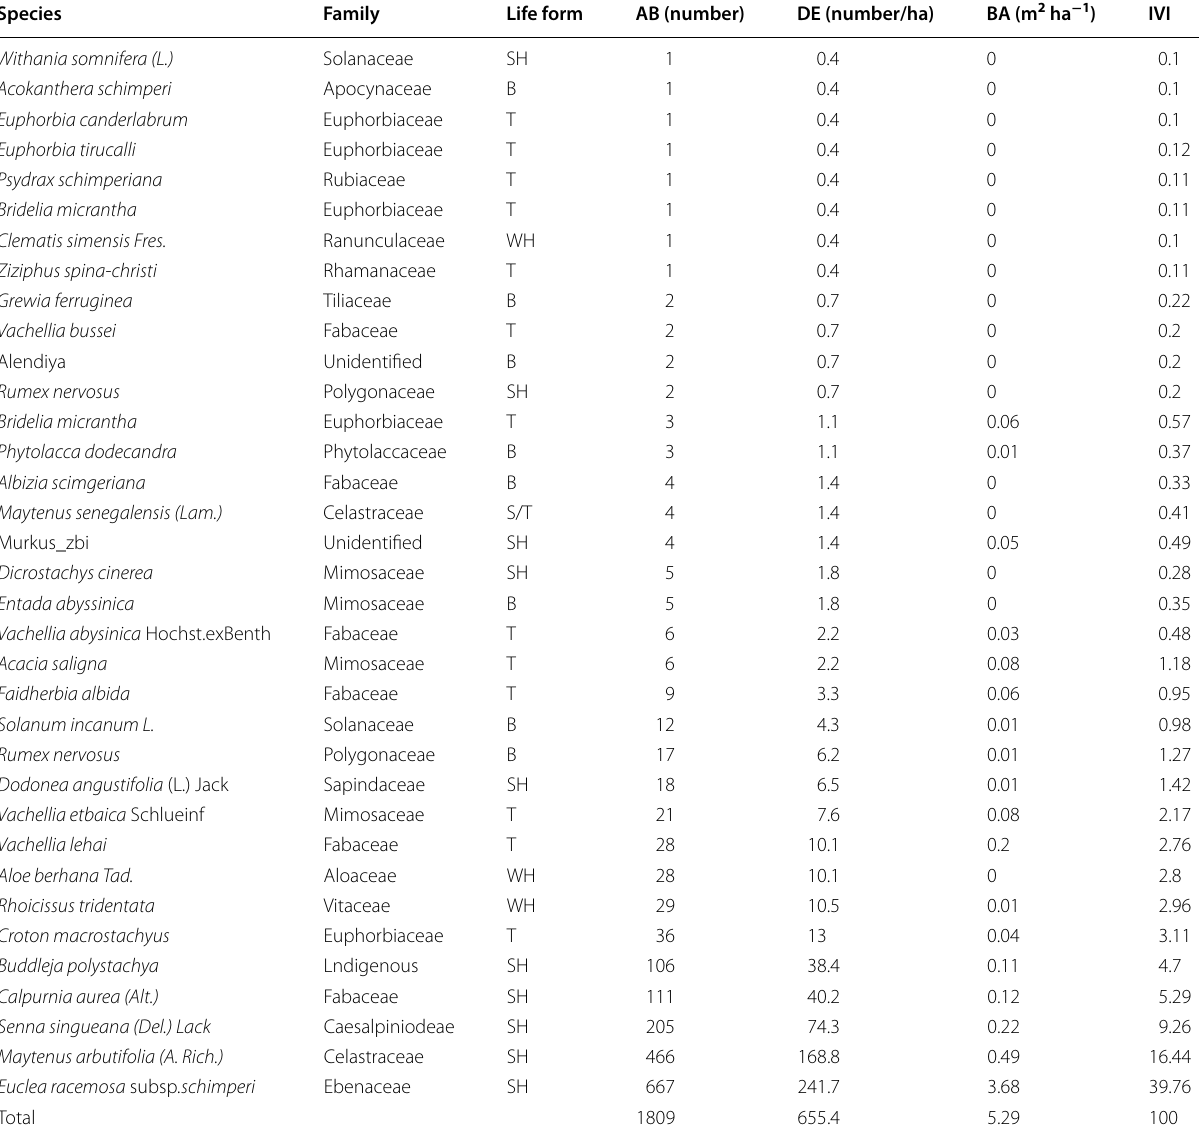
Table 2 Abundance (AB), density (DE), basal area (BA) and importance value index (IVI) of woody plants in quarry